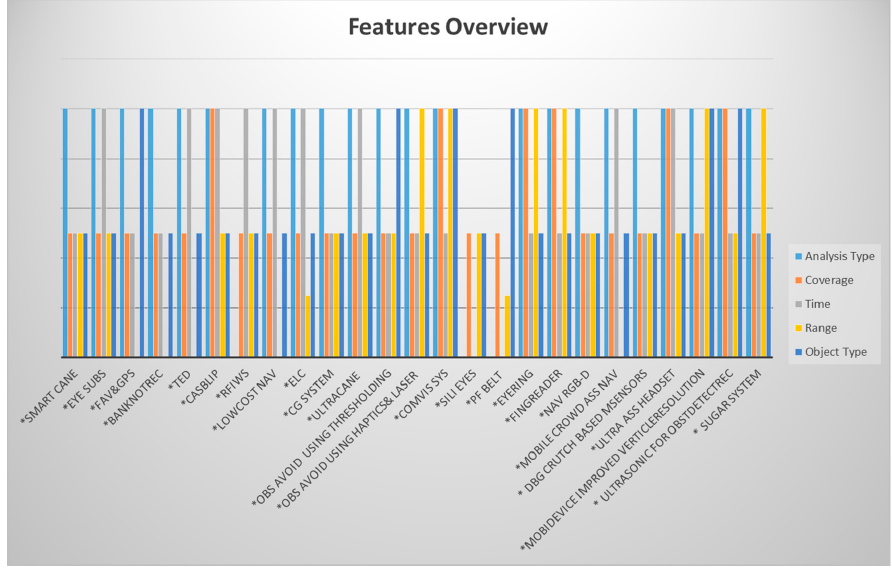
Figure 43. Features’ overview for each system.